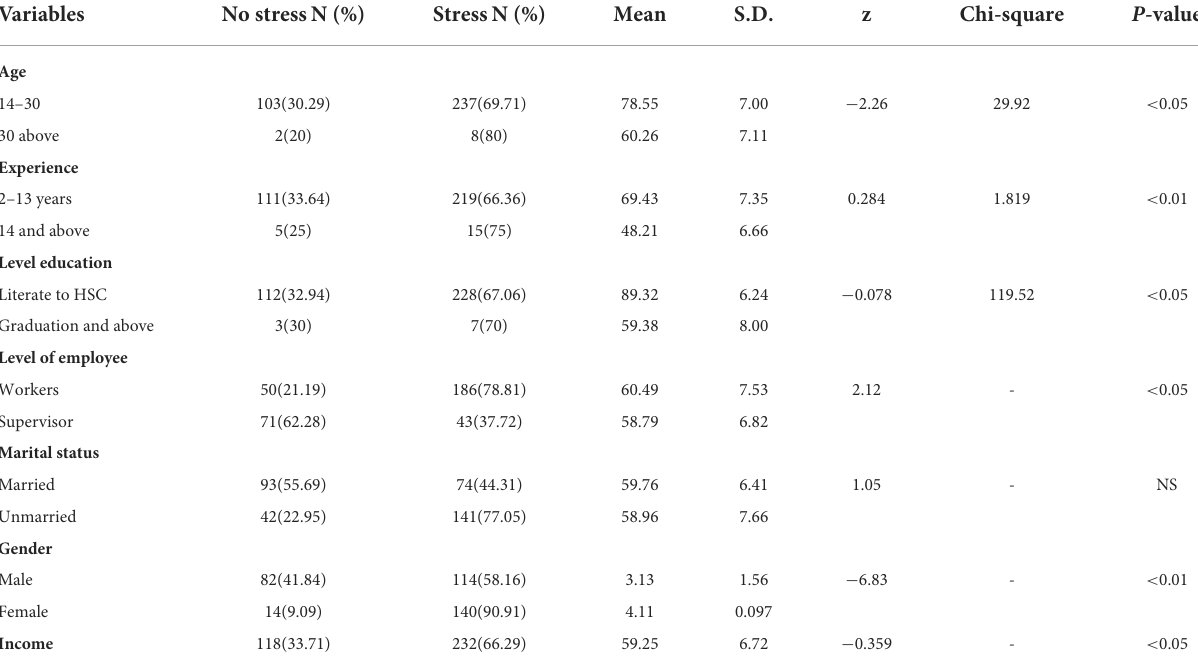
TABLE 6 Occupational stress based on Siegrist Scale and distribution of demographic